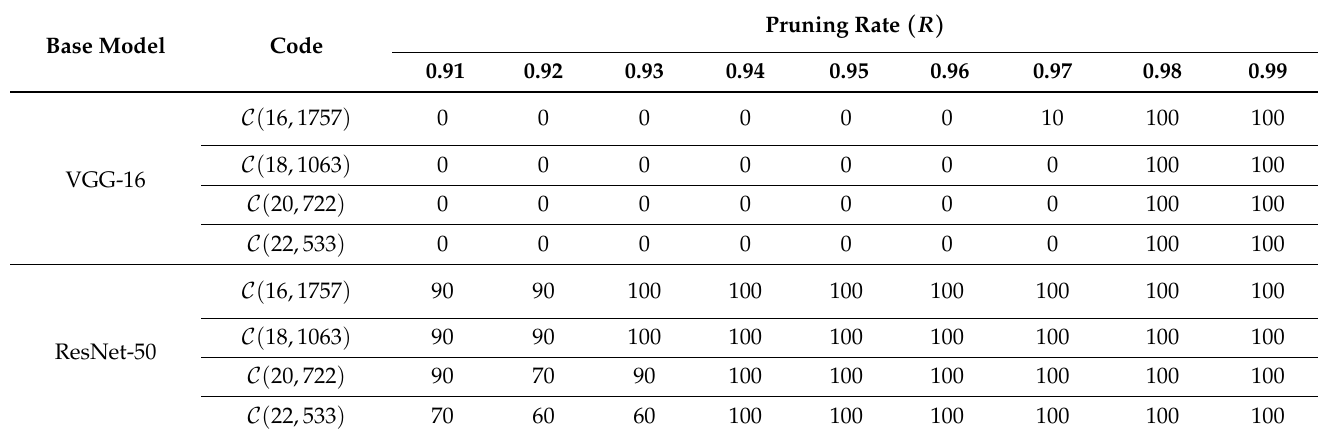
Table 4. Error rate against pruning attacks after retraining.